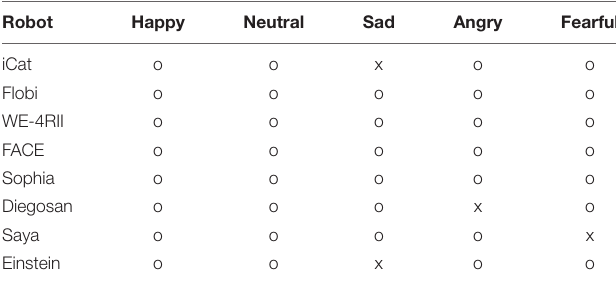
TABLE 1 | Available emotions per robot (o = present, x =